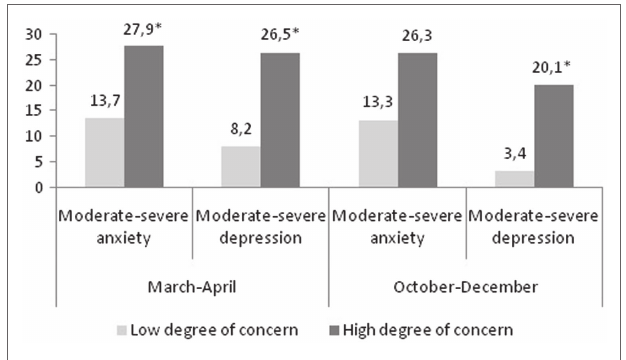
FIGURE 1 | Association between degree of concern for employment status and mental